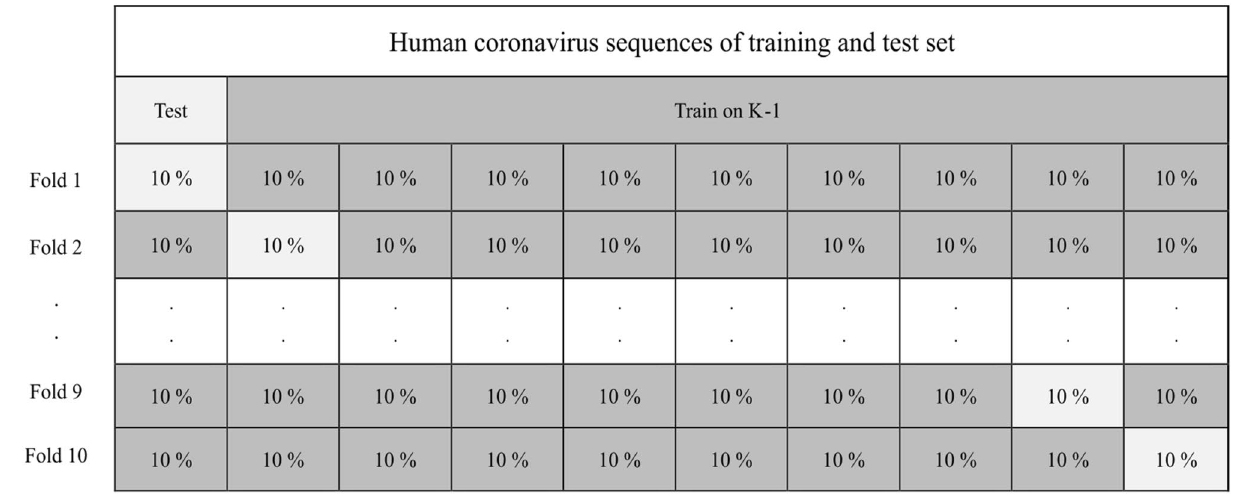
Figure 8. Tenfold cross-validation